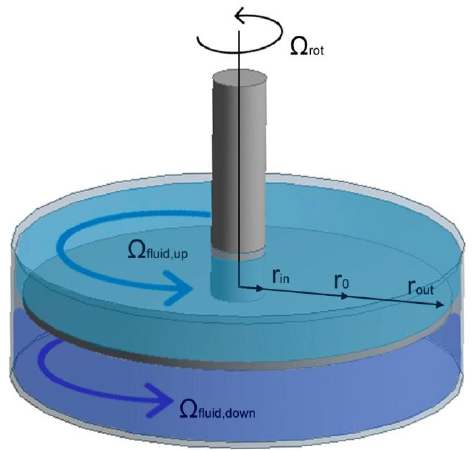
Figure 1. Model for a confined